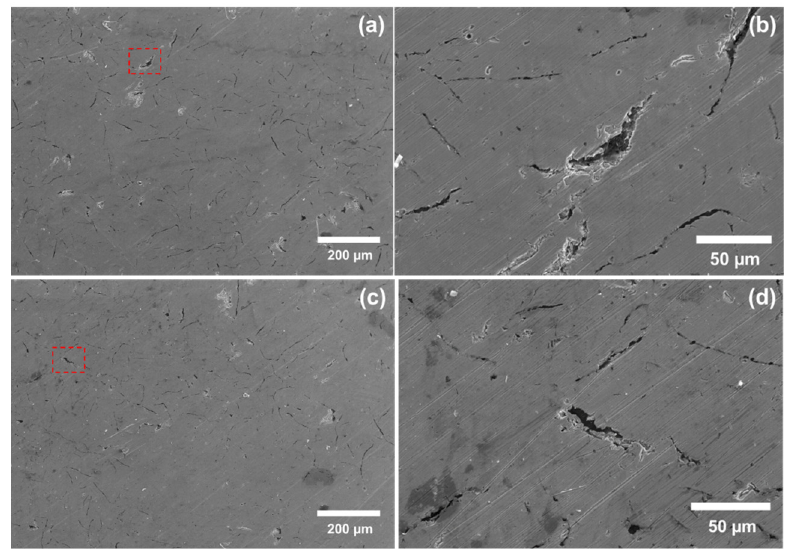
Figure 7. SEM micrographs of cast iron sample exposed to engine coolant containing 100 ppm chloride for 28 days are shown in ( a ) through ( d ). (Note: ( b ) and ( d ) illustrates high magnification SEM micrographs of highlighted regions in ( a ) and ( c ), respectively).